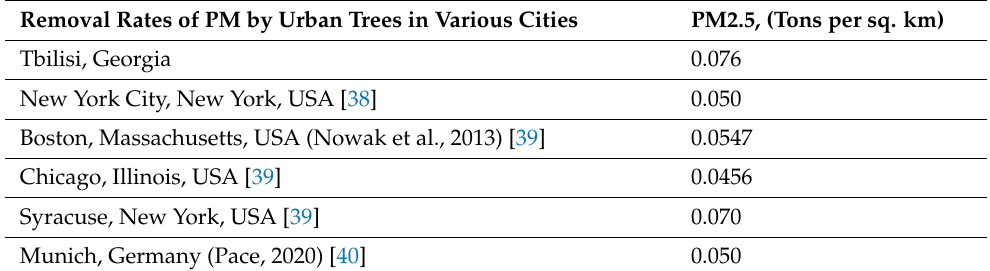
Table 4. Removal rates of Particulate Matter, PM2.5 (tones per sq. km) in various cities. Removal Rates of PM by Urban Trees in Various